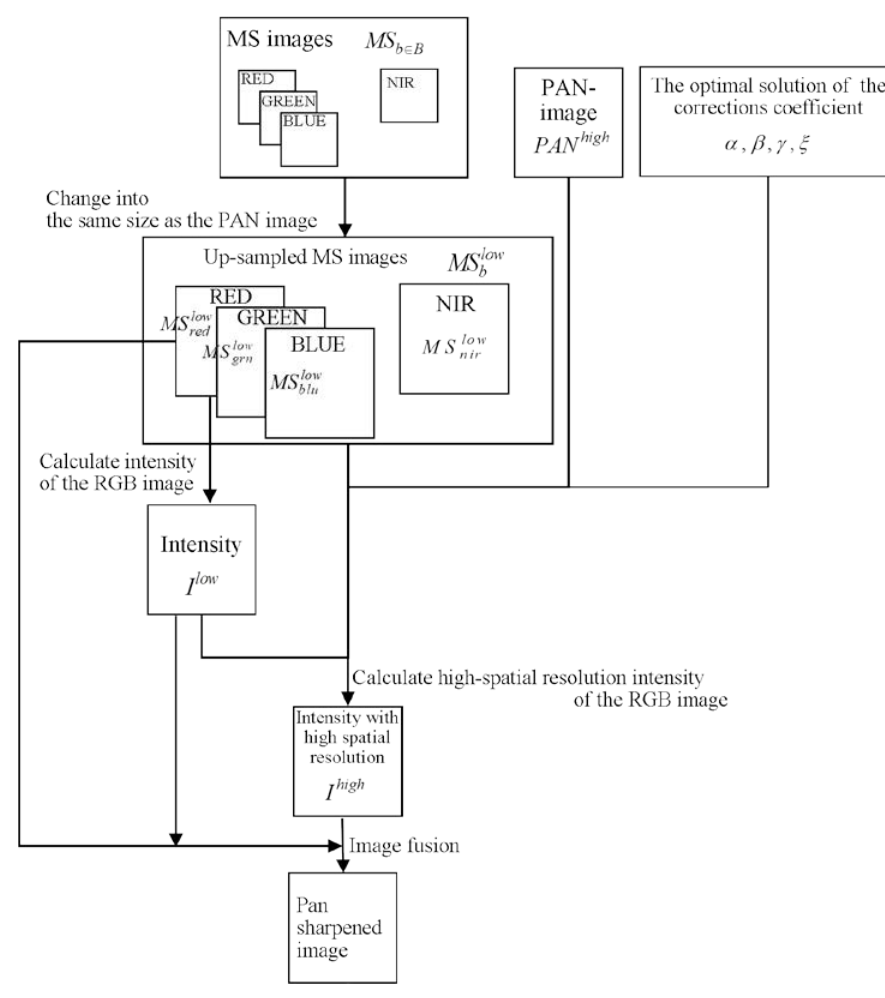
Figure 2. Fusion process diagram of the proposed method.